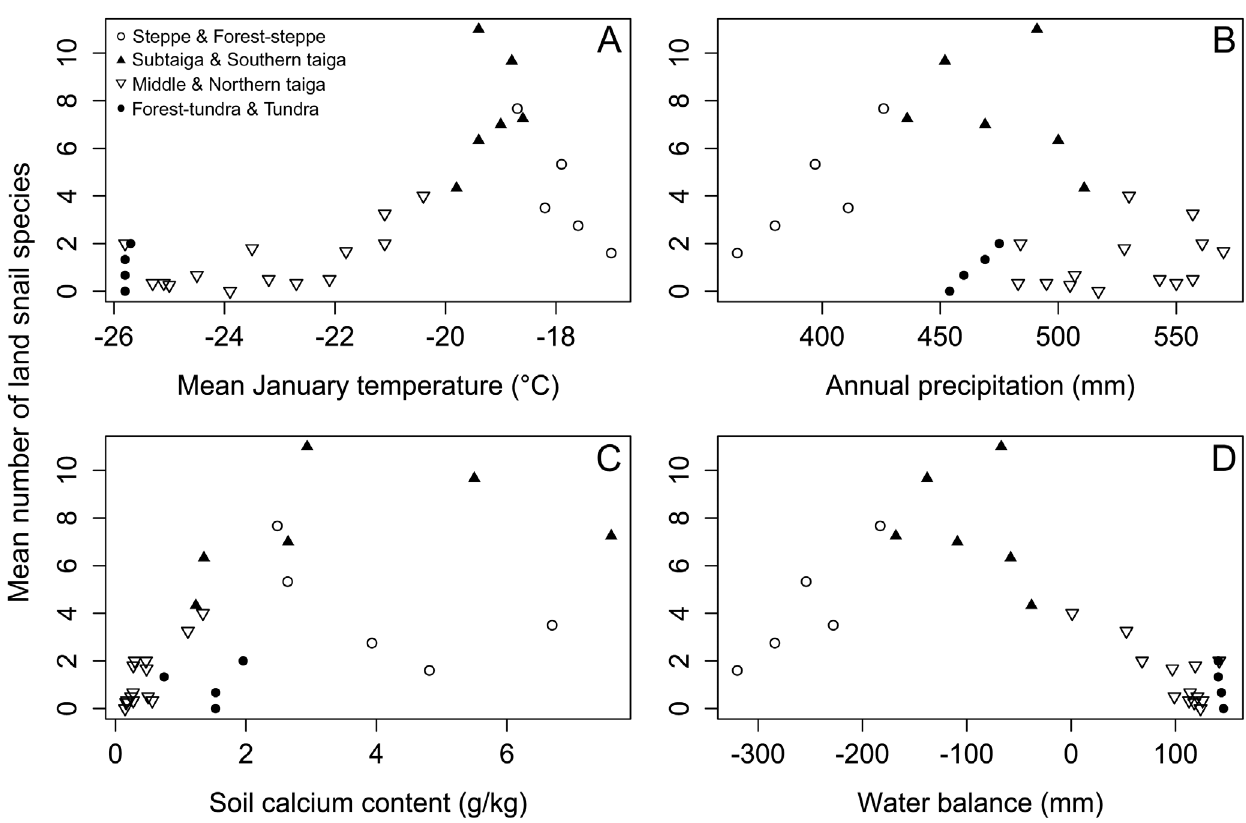
Figure 3. Changes in mean numbers of land snail species in relation to four environmental variables.